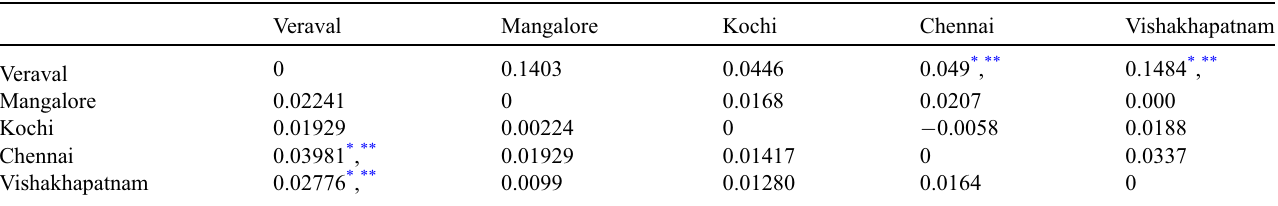
Table 2. Pair-wise F ST (below diagonal) and R ST (above diagonal) values among fi ve locations of S. commerson with 12 microsatellite loci.